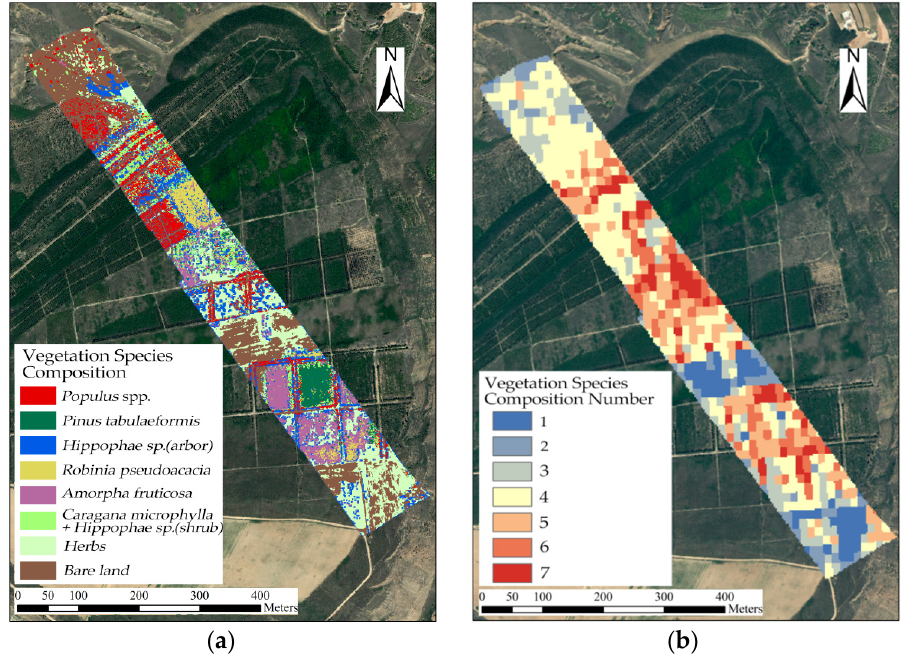
Figure 19. Estimation results of ( a ) fine identification and classification of seven vegetation species compositions in the study area: Populus, Pinus tabuliformis, Sea buckthorn (arbor), Robinia pseudoacacia, Amorpha fruticosa , Caragana microphylla + Sea buckthorn (shrub), herbs, and bare land; ( b ) vegetation species composition number; the numbers 1 to 7 represent the number of vegetation species compositions in a specific patch.